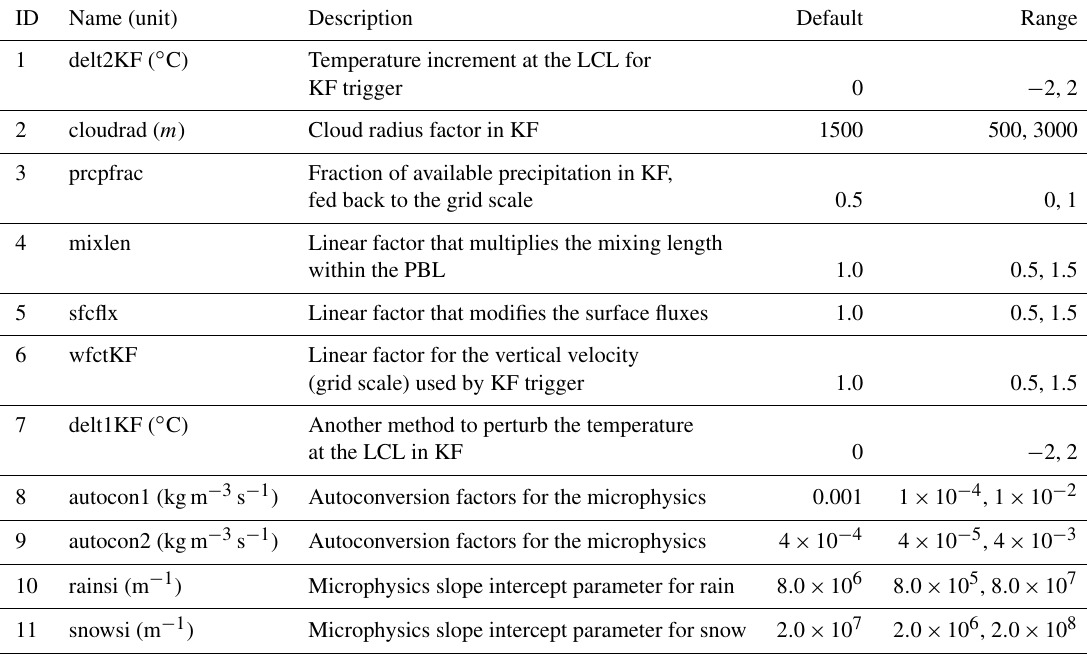
Table 1. The 11 parameters studied in this paper. Also shown are the default values and the range over which they are varied. ID Name (unit) Description Default Range delt2KF ( ◦ C) Temperature increment at the LCL for KF trigger 0 − 2, 2 cloudrad ( m ) Cloud radius factor in KF 1500 500, 3000 prcpfrac Fraction of available precipitation in KF, fed back to the grid scale 0.5 0, 1 mixlen Linear factor that multiplies the mixing length within the PBL 1.0 0.5, 1.5 sfcflx Linear factor that modifies the surface fluxes 1.0 0.5, 1.5 wfctKF Linear factor for the vertical velocity (grid scale) used by KF trigger 1.0 0.5, 1.5 delt1KF ( ◦ C) Another method to perturb the temperature at the LCL in KF 0 − 2, 2 autocon1 (kgm − 3 s − 1 ) Autoconversion factors for the microphysics 0.001 Autoconversion factors for the microphysics Microphysics slope intercept parameter for rain Microphysics slope intercept parameter for